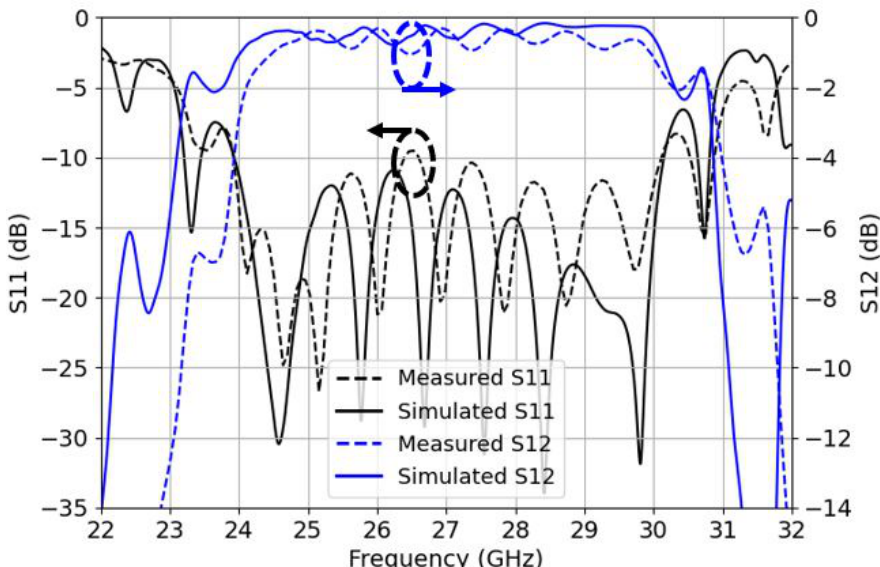
Figure 10. Top-side back-to-back S11 reflection coefficients (left y-axis) in black and insertion losses S12 (right y-axis) in blue for the measurements and simulations.